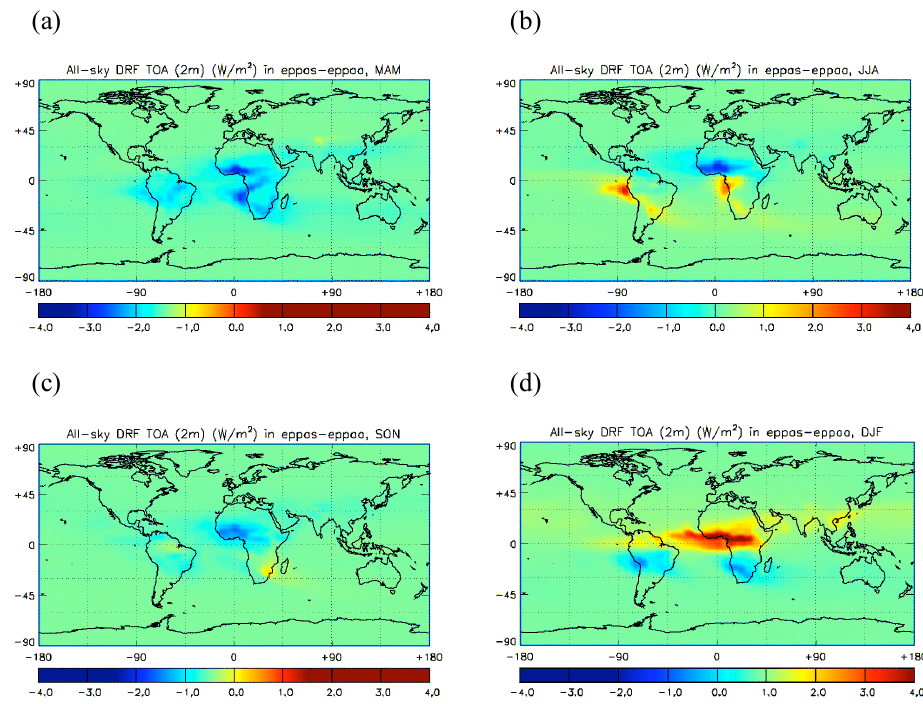
Fig. 2. Differences in aerosol direct radiative forcing (DRF) in W/m 2 at top of the atmosphere (TOA) due to the seasonality of BBCA emissions in offline runs; shown as means over the months of: (a) MAM, (b) JJA, (c) SON, and (d)